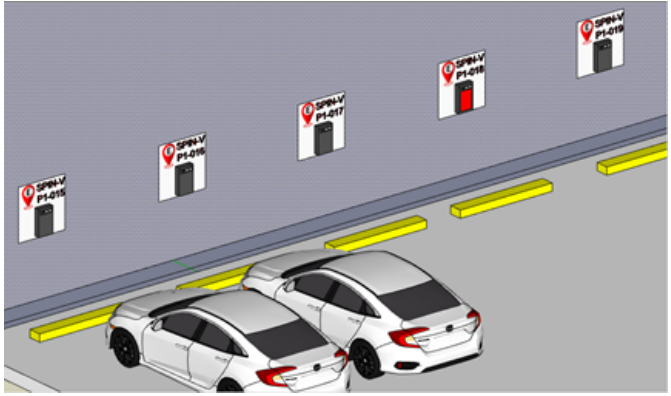
Figure 12. SPIN-V installed in the back end of the parking space for either commercial or residential